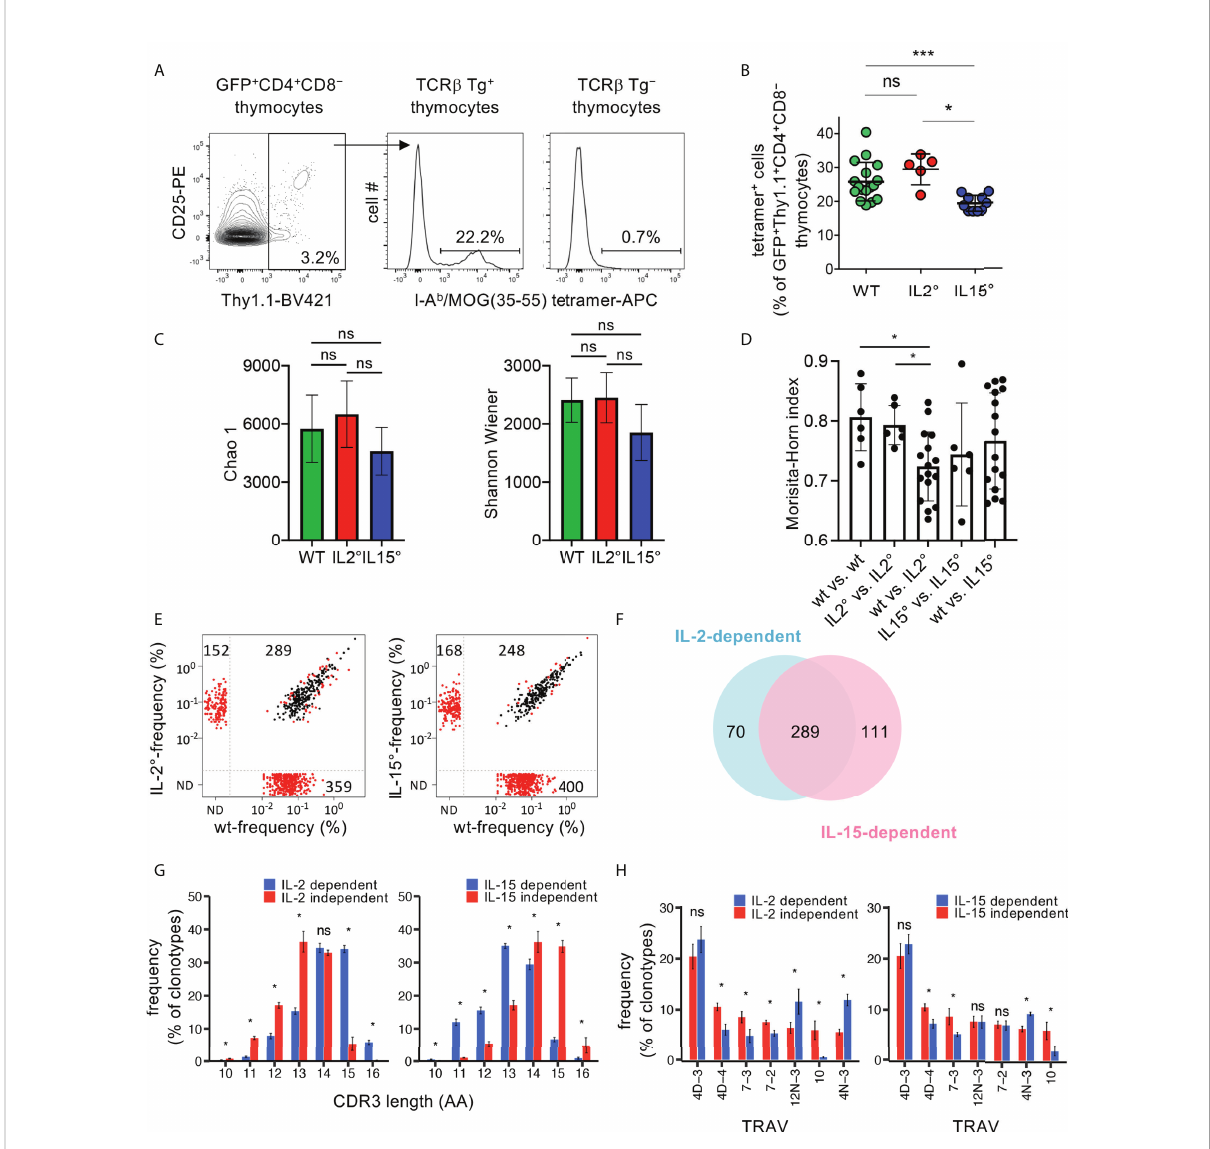
FIGURE 3 The TCR-repertoires expressed by Treg developing in an IL-2 and IL-15-dependent manner are partially distinct. (A) Flow-cytometry analysis of thymocytes from Rag2-Gfp Foxp3-Thy1 a Kaa TCR b -transgenic (Tg + ) or non-transgenic (Tg − ) mice. Representative I-A b /MOG (35 – 55) tetramer- stainings on GFP + Thy1.1 + CD4 + CD8 − wt thymocytes (i.e. newly developed Treg) are shown. (B) Proportions of tetramer positive cells, gated as in (A) , in wt (n=17), Il2° (n=5), and Il15° (n=10) mice. Dots indicate individual mice. (C – H) TCRseq analysis of TCR a repertoires expressed by newly developed Treg from Rag2-Gfp Foxp3-Thy1 a Tcra +/ ° Kaa TCR b -transgenic wt (n=4), Il2° (n=4) and Il15° (n=4) mice. (C) Chao1 and Shannon- Wiener diversity of the TCR-repertoires. (D) Morisita-Horn similarity between all individual samples from indicated mice based on clonotypes with ≥ 5 UMIs. Dots indicate distinct comparisons. (E) Frequency of individual clonotypes in the public TCR-repertoire expressed by Treg from indicated mice. Red dots indicate clonotypes differentially expressed between wt and mutant Treg (p< 0.05, LIMMA test). N.D., not detected. (F) Venn diagram showing the partial overlap of the IL-2 and the IL-15-dependent public clonotypes (i.e. those within the lower-right quadrants in (E) . (G) Distribution of the TCR a CDR3-lengths of IL-2 and the IL-15-dependent and -independent public clonotypes (lower-right vs. upper- right quadrants in E, respectively). CDR3 a start with conserved Cys and Ala and end with conserved Phe. See Figure S4 for average CDR3- lengths. (H) TRAV- (TCR V a -segment-) usage in the indicated groups of TCR a clonotypes. Only TRAV represented at ≥ 5% in at least one indicated group are shown. See Figures S5, S6 for clonotypes found only in cytokine-de fi cient mice (upper-left quadrants in (E) . ns, not signi fi cant; *p < 0.05; ***p < 0.001 (Mann-Whitney test). Bars indicate mean values ±